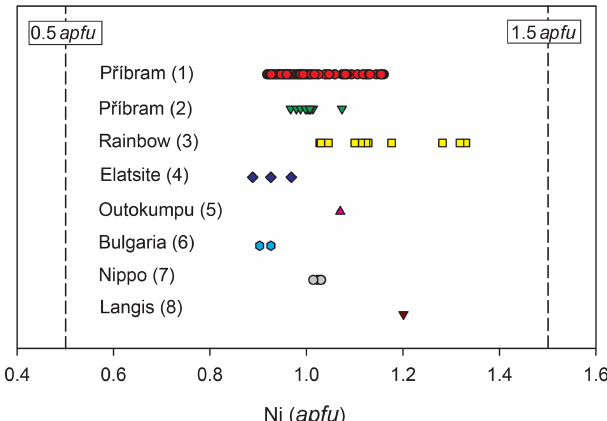
Figure 5. Determined range of Ni contents in grimmite. (1) Pˇríbram (this paper). (2) Pˇríbram – grain used for SCXRD study (this pa- per). (3) Rainbow hydrothermal field, Mid-Atlantic Ridge (Lee et al., 2002). (4) Elatsite deposit, Bulgaria (Dragov and Petrunov, 1998). (5) Outokumpu mining district, Finland (Criddle and Stan- ley, 1993). (6) Muzho and Bakura deposits, Bulgaria (Min ˇ ceva- Stefanova, 1975). (7) Nippo ore deposit, Japan (Imai et al., 1973). (8) Langis mine, Canada (Petruk et al.,